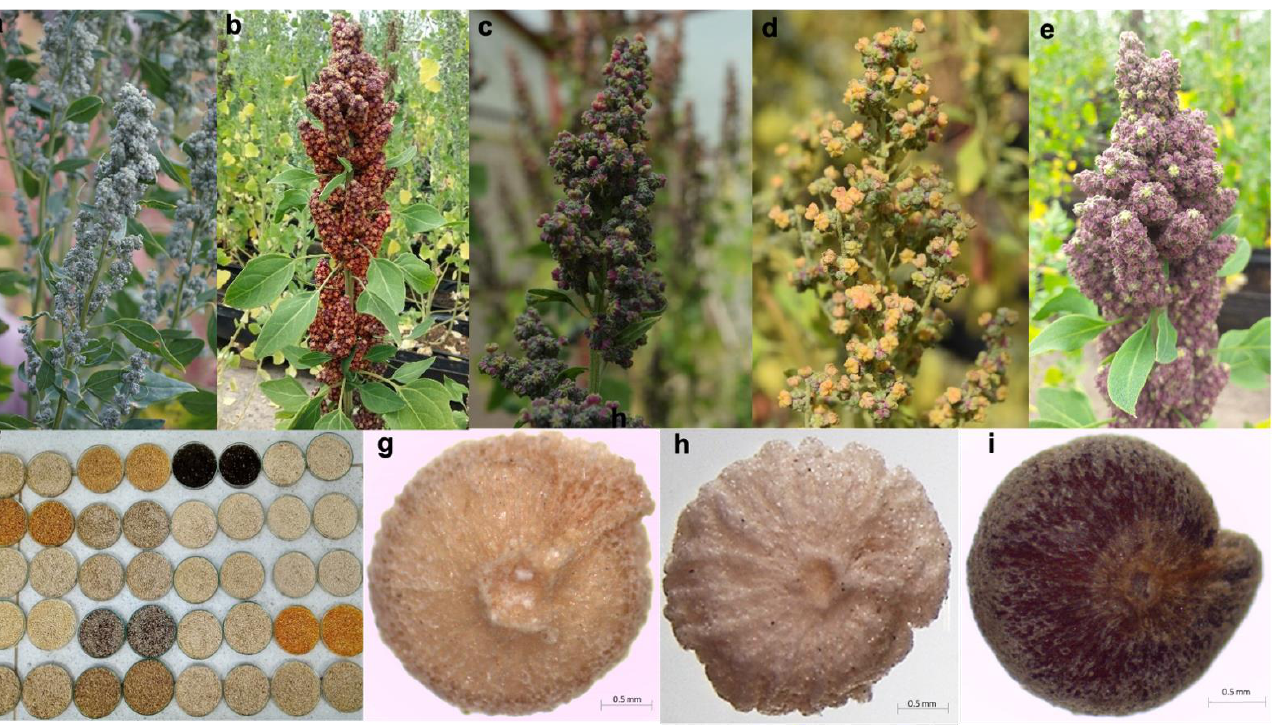
Figure 4. ( a ) Lax green panicles; ( b ) Compact, amarantiform, and purple; ( c ) Loose, and green and purple; ( d ) Lax with a mix of green and yellow; ( e ) Compact purple panicle; ( f ) Color of the seed episperm; ( g ) Seed with a beige intermediate border; ( h ) Seed with beige wavy edge; ( i ) Smooth edge seed with brown perigonium.